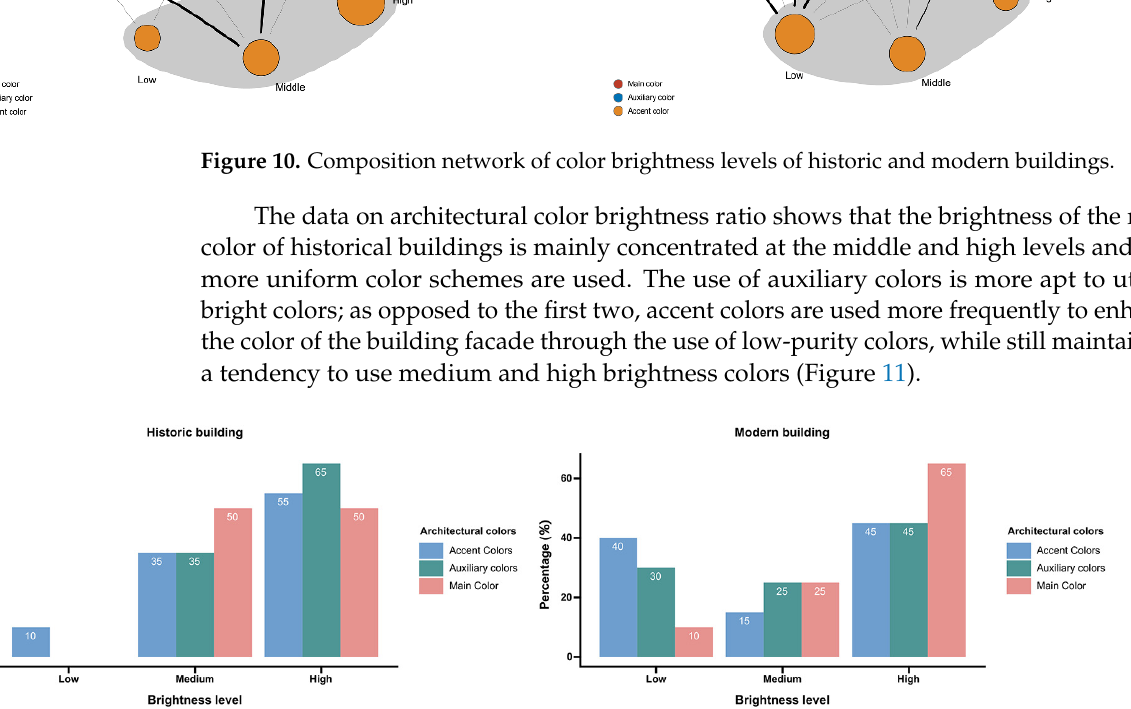
Figure 11. Percentage of the luminosity of historic and modern buildings.